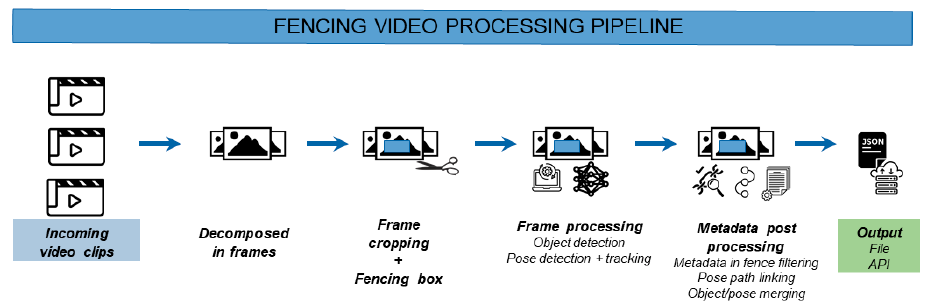
Figure 1. Different steps in the video processing pipeline to produce segment path data.